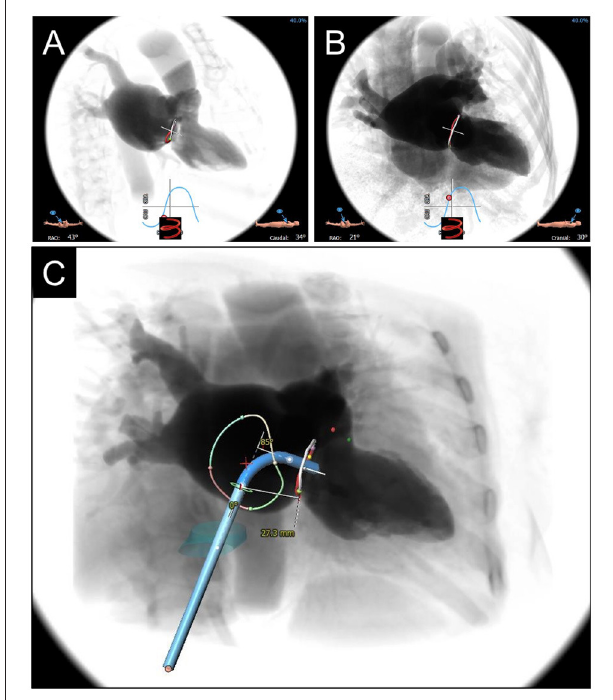
FIGURE 5 | CCTA-based Fluoroscopic Simulation for TMVR access planning. Projected Fluoroscopic coplanar angles can be found along the displayed S-curve. A coplanar working view (A) and modified 4-chamber view (B) are displayed for a planned valve-in-ring procedure. (C) Full transseptal access planning is shown, with a projected catheter path through the IVC (turquoise cylinder) and across the interatrial septum for coaxial valve implantation from the working view. Catheter bend angle is displayed (85 degrees) and ideal entry distance from the mitral annulus